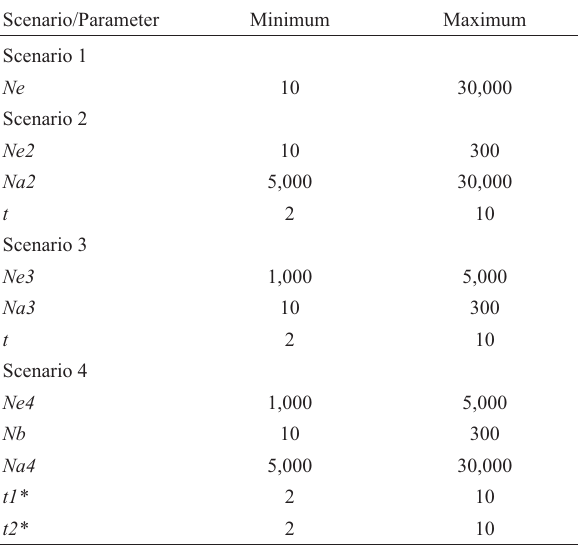
Table 2 - Summary statistics for 10 microsatellite loci genotyped for the humpback whale population off Brazil. Rep, repeat motif length in base pairs; K , number of alleles; H O , observed heterozygosity; H E , expected heterozygosity; F IS , inbreeding coefficient (* P < 0.005 based on 180 randomizations).